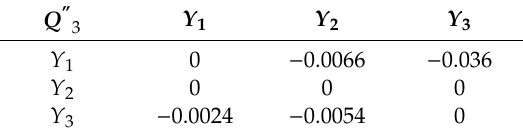
Table 32. The regret matrix Q (cid:48)(cid:48) 3 .